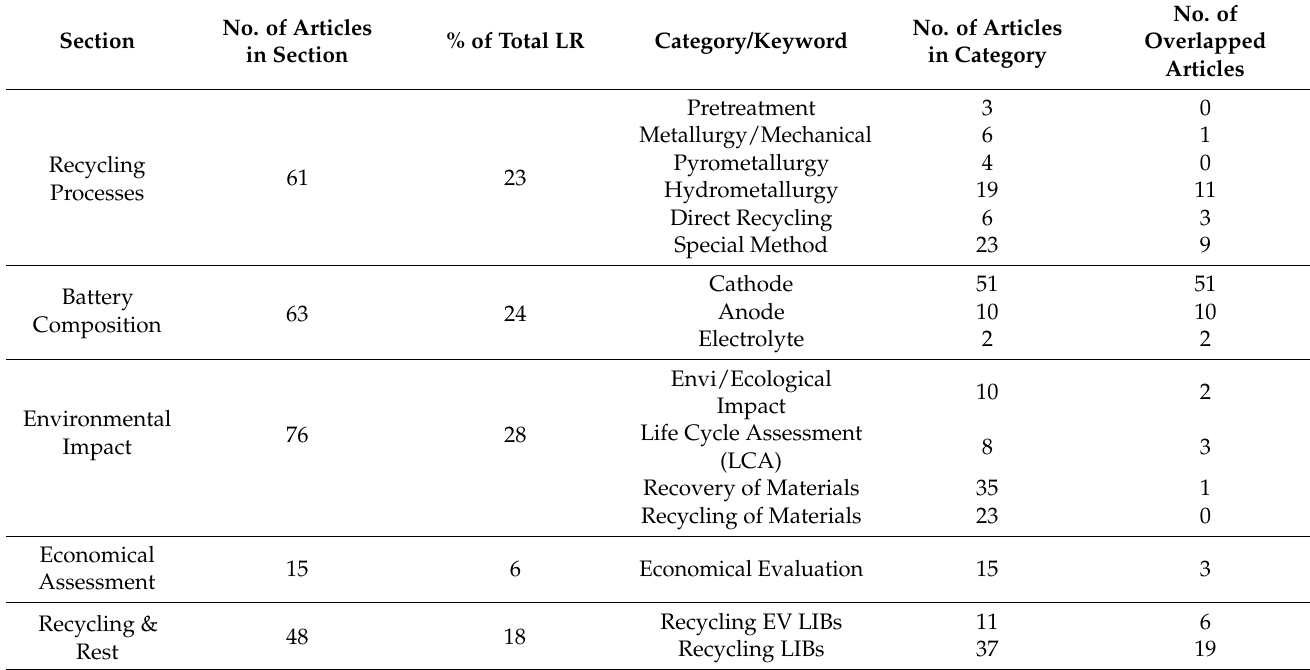
Table 3. Distribution of publications, the methodology of performed literature